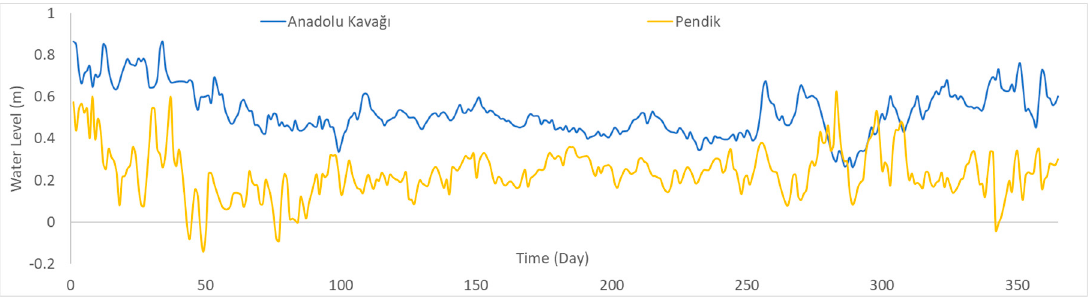
Figure 3. Daily water-level values in the Pendik and Anadolu Kava˘gı mareography stations in 2003.